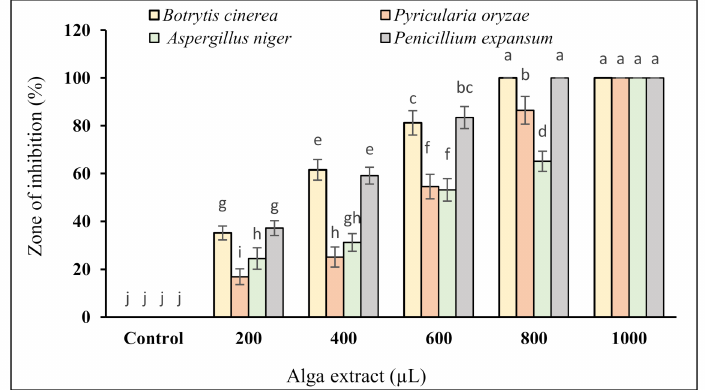
Figure 5. The effect of the G. persica extracts at volumes, 200, 400, 600, 800, and 1000 µ L on the mycelial growth inhibition of B. cinerea , P. oryzae , A. niger , and P. expansum (columns are mean SD ± 3 replications, vertical bars show standard deviation, and different letters imply significant differences at the p < 0.05 level based on Duncan’s